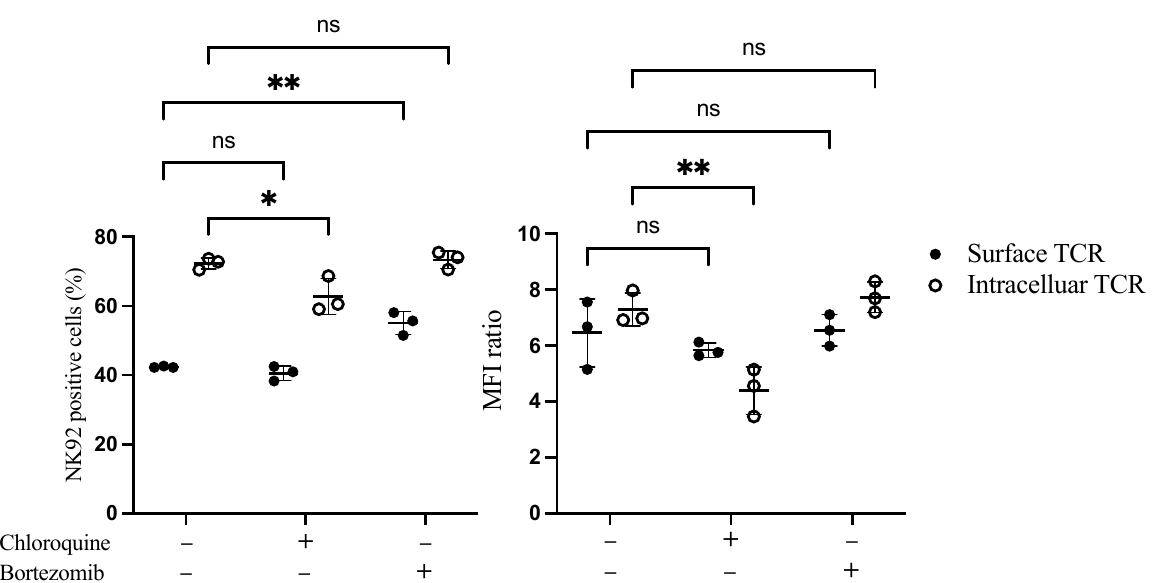
Figure 3. Flow cytometry-based TCR expression upon treatment of TCR/CD3 transduced NK92 cells with bortezomib and chloroquine inhibitors. NK92 cells were transduced with TCR as a first transgene on day 0, then transduced with CD3 subunits as a second transgene on day 1. Transduced NK92 cells were kept in the culture for at least for 2 weeks. Then they were incubated with proteasome inhibitor bortezomib or lysosomal inhibitor chloroquine for 20 h. Cells were harvested and stained for TCR expression assessment. Live cells were pre-gated during data analysis by FlowJo to obtain TCR- positive NK92 cells. Each dot represents the mean of duplicate data; three independent experiments were performed. ns indicates not significant. * p < 0.05; ** p <